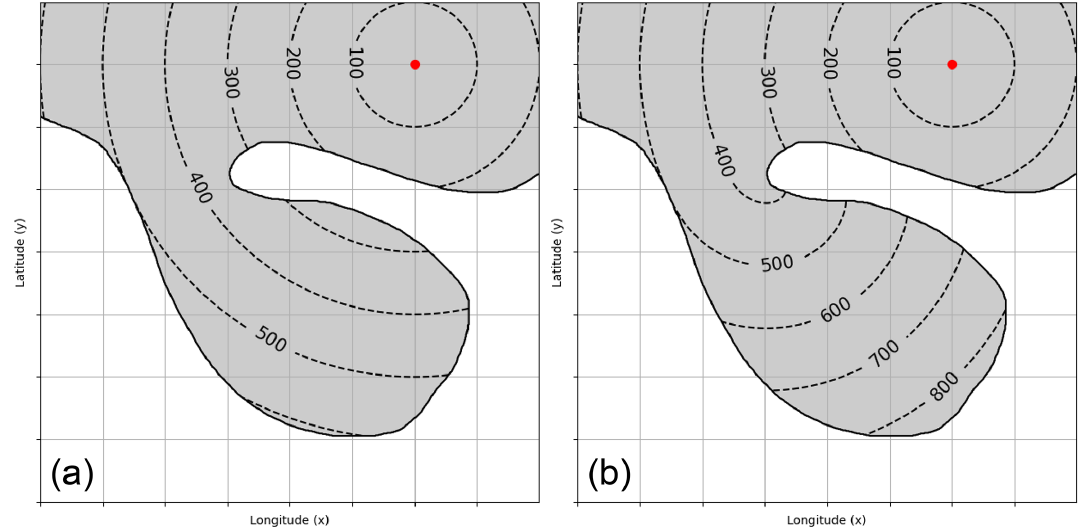
Figure 2. A visual example (same PVS-like structure as in Fig. 1) showing the shortest distance measure required for the algorithm. (a) Start- ing at the red dot, the direct spherical distance is shown, which can be calculated easily. (b) The distance following a well-defined domain (e.g., PV field) is computed using a fast marching method (FMM) as required by our strategy; see Sect. 3.2 for details.